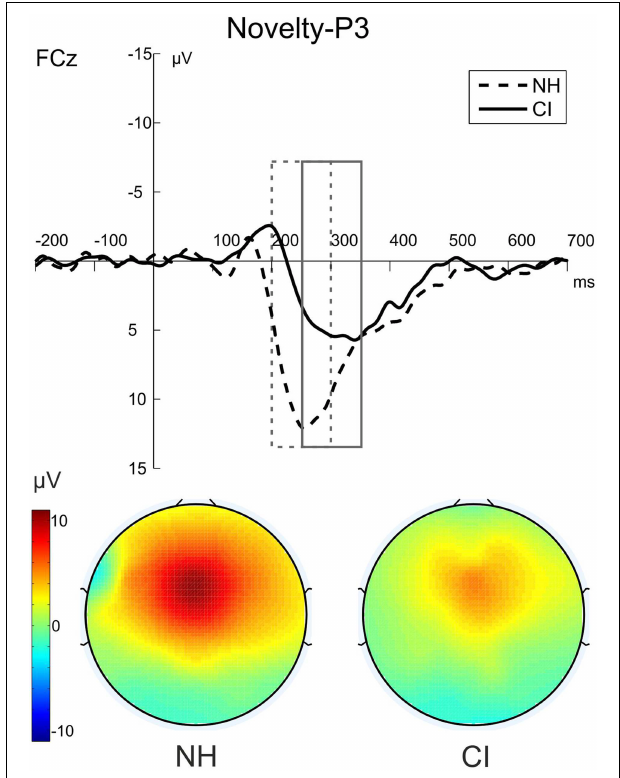
FIGURE 6 | The novelty-P3 (novel-standard difference waveforms) for NH participants (dashed) and CI users (solid) in the auditory-visual DFD. The figure shows the ERPs at FCz and the voltage maps illustrating the mean over the analyzed time window for NH participants (200–300ms) on the left and for CI users (250–350ms) on the